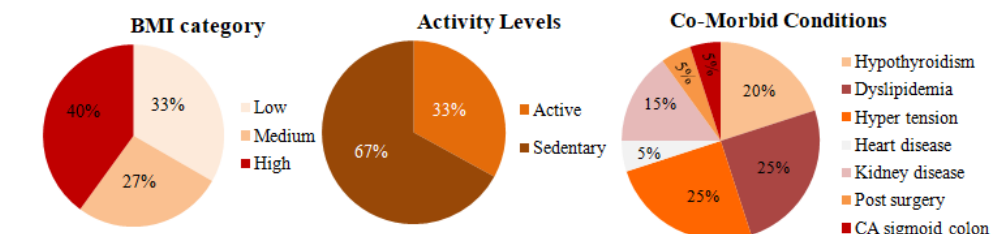
Figure 15. Patient data.